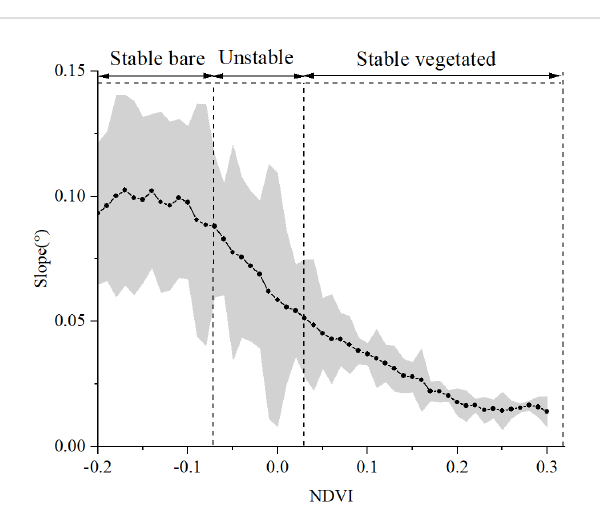
FIGURE 8 Variation of slope as a function of NDVI in 2011. Black dots in gray standard deviation denote the mean slope change within the NDVI interval of 0.01. The NDVI zonation refers to Figure 6B.